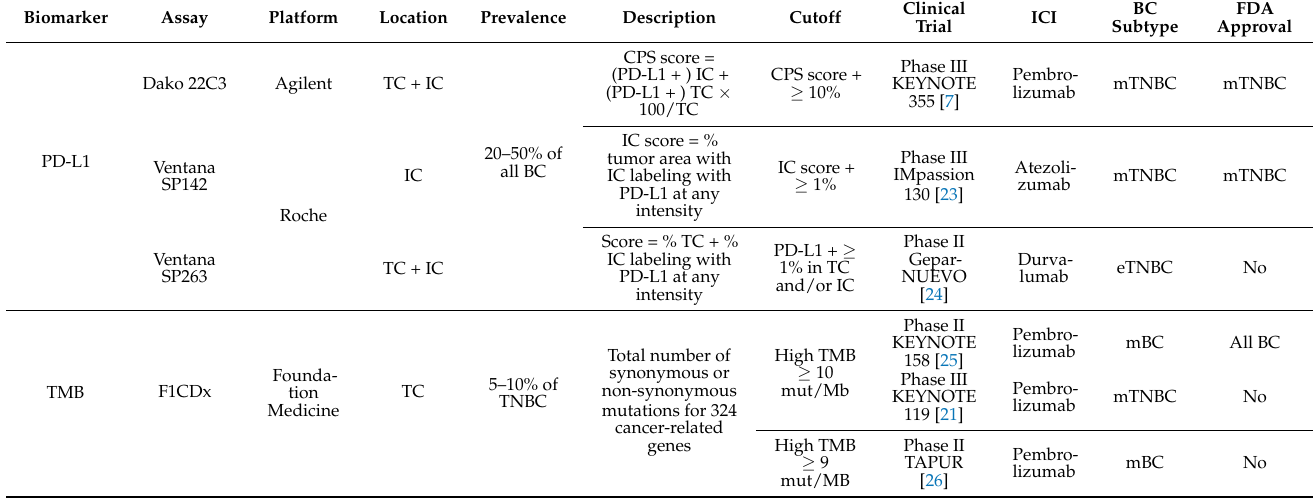
Table 1. Clinically approved and evolving predictive biomarkers for a response to